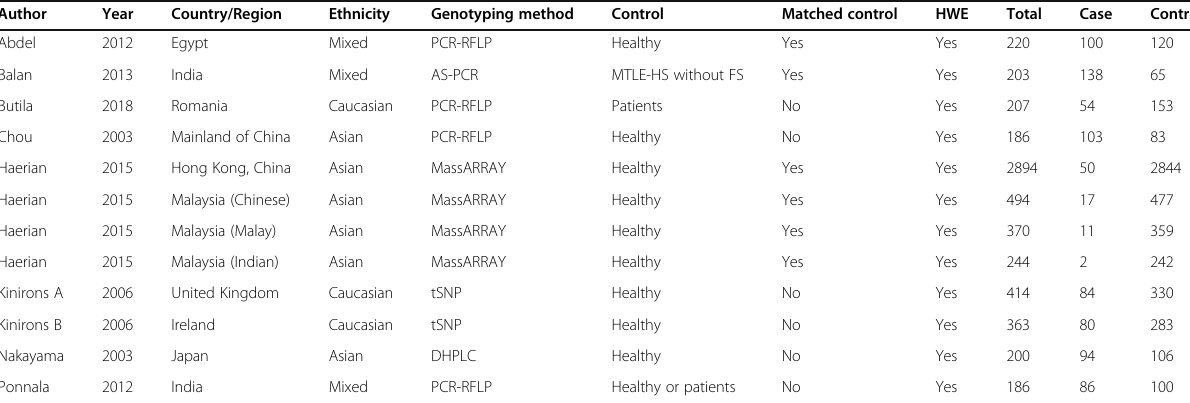
Table 1 Baseline characteristics of eligible case-control studies Author